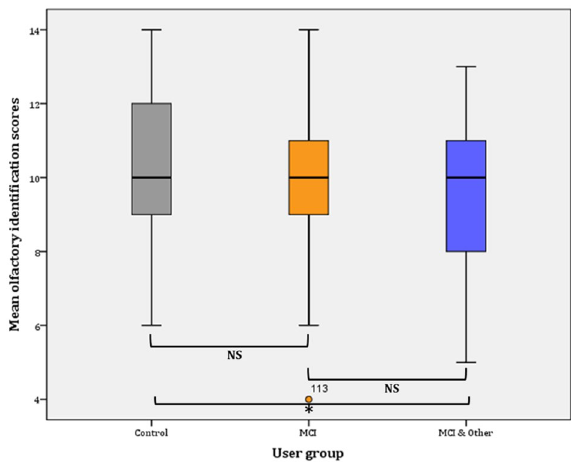
Figure 4. Mean olfactory identification scores (Phase